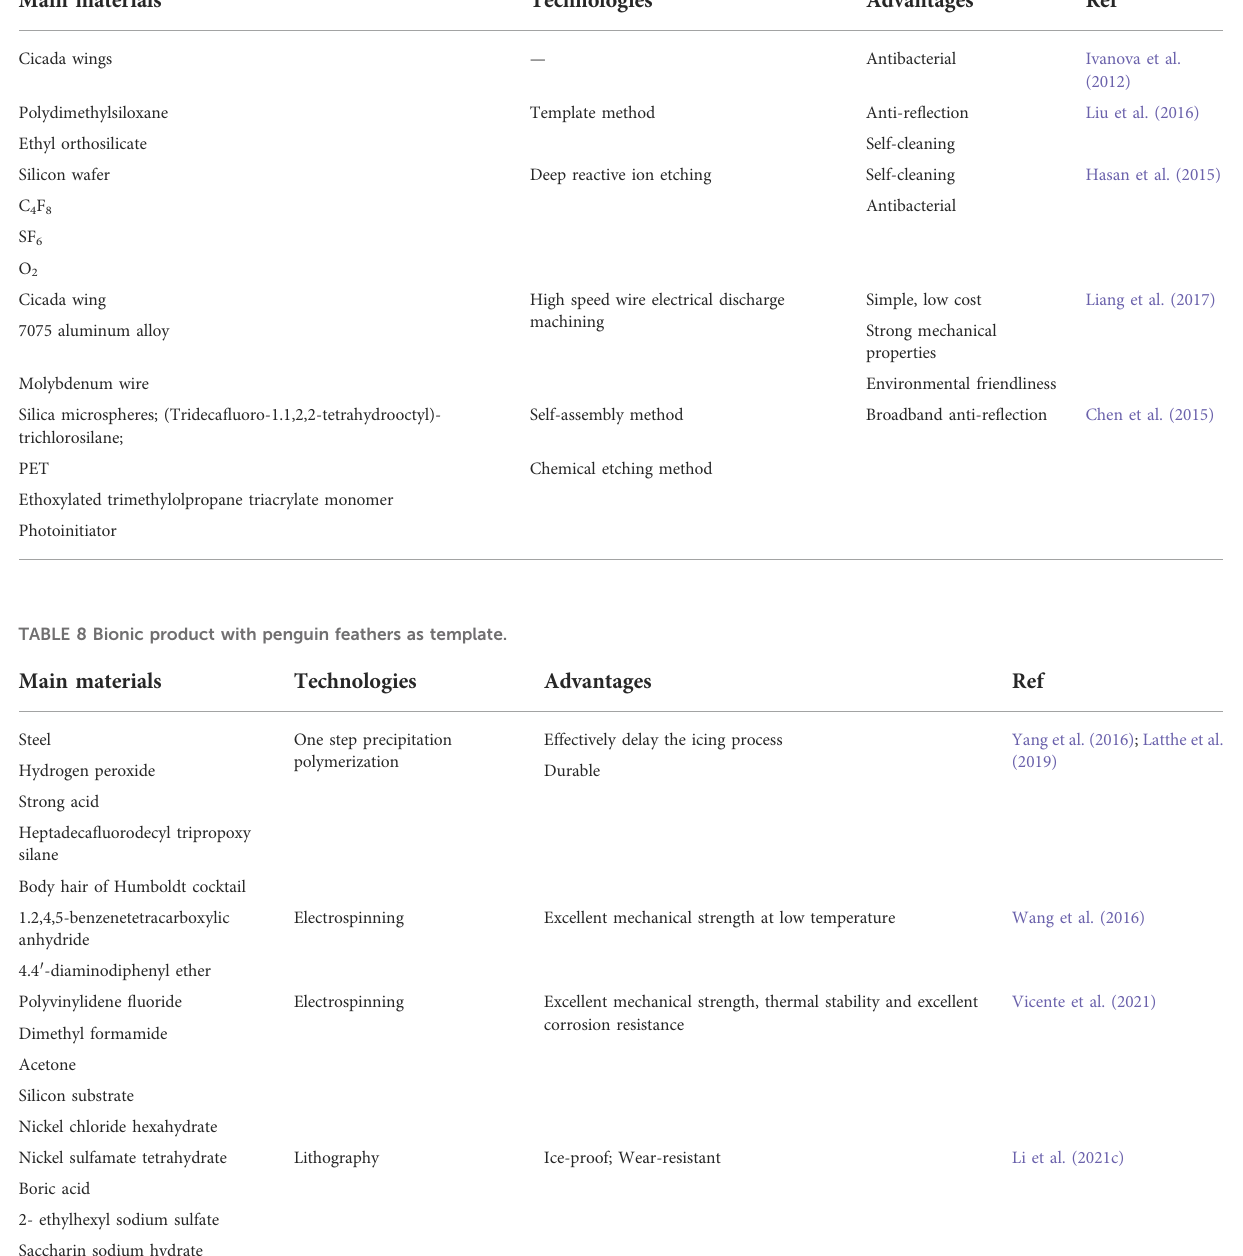
TABLE 7 Bionic product with cicada wings as template.